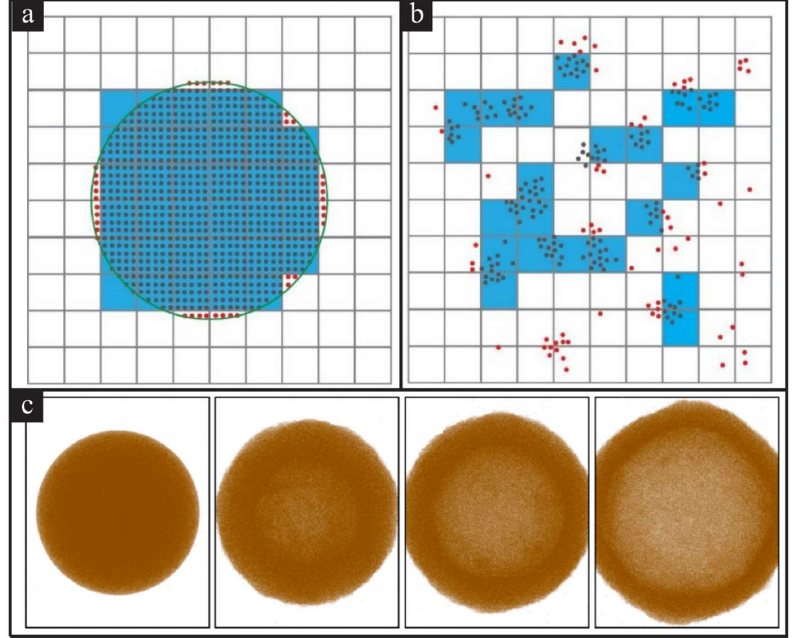
Figure 4. Schematic representation of the conventional approach of TTM-MD and its results. The TTM-MD calculations will be performed in cells colored blue ( a ) The initial configuration of the nanoparticle; ( b ) the atomistic distribution after fragmentation; ( c ) “cold” shell formed from homogeneously heated nanoparticle in a vacuum [22]. Reprinted with permission from Ref. [22]. Copyright 2015 American Chemical Society.